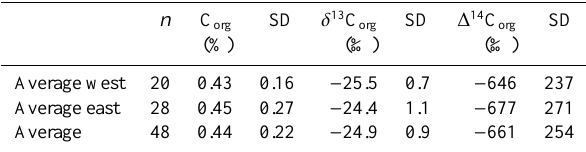
Table 1. Average composition of fluvial OC in rivers draining the eastern and western flanks of Taiwan (Table S1) and the average input assuming approximately equal input of sediment from both sides of the mountain range (Dadson et al., 2003; Kao and Milliman,